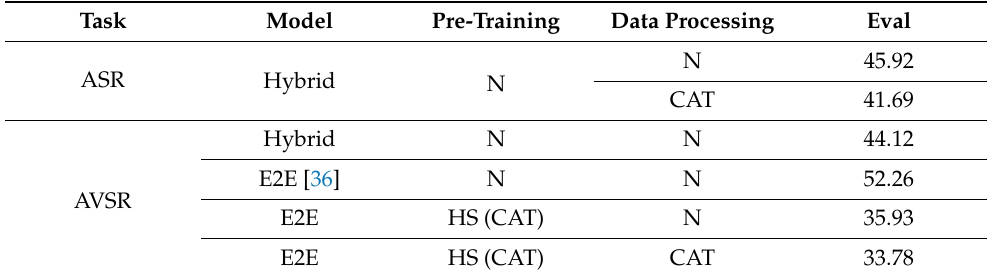
Table 1. The results (CER %) of hybrid system pre-training. HS means the hybrid system. CAT means splicing the continuous